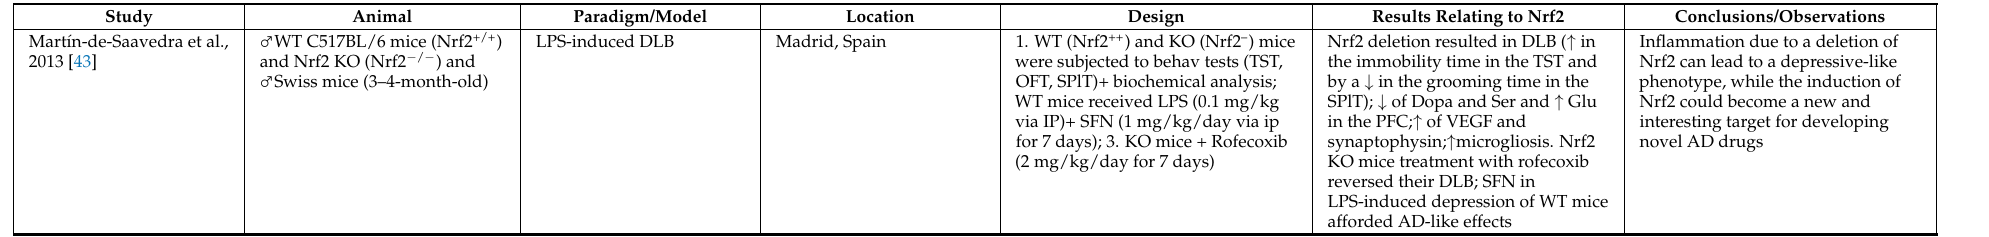
Table 2. Summary of animal studies investigating the role of Nrf2 in